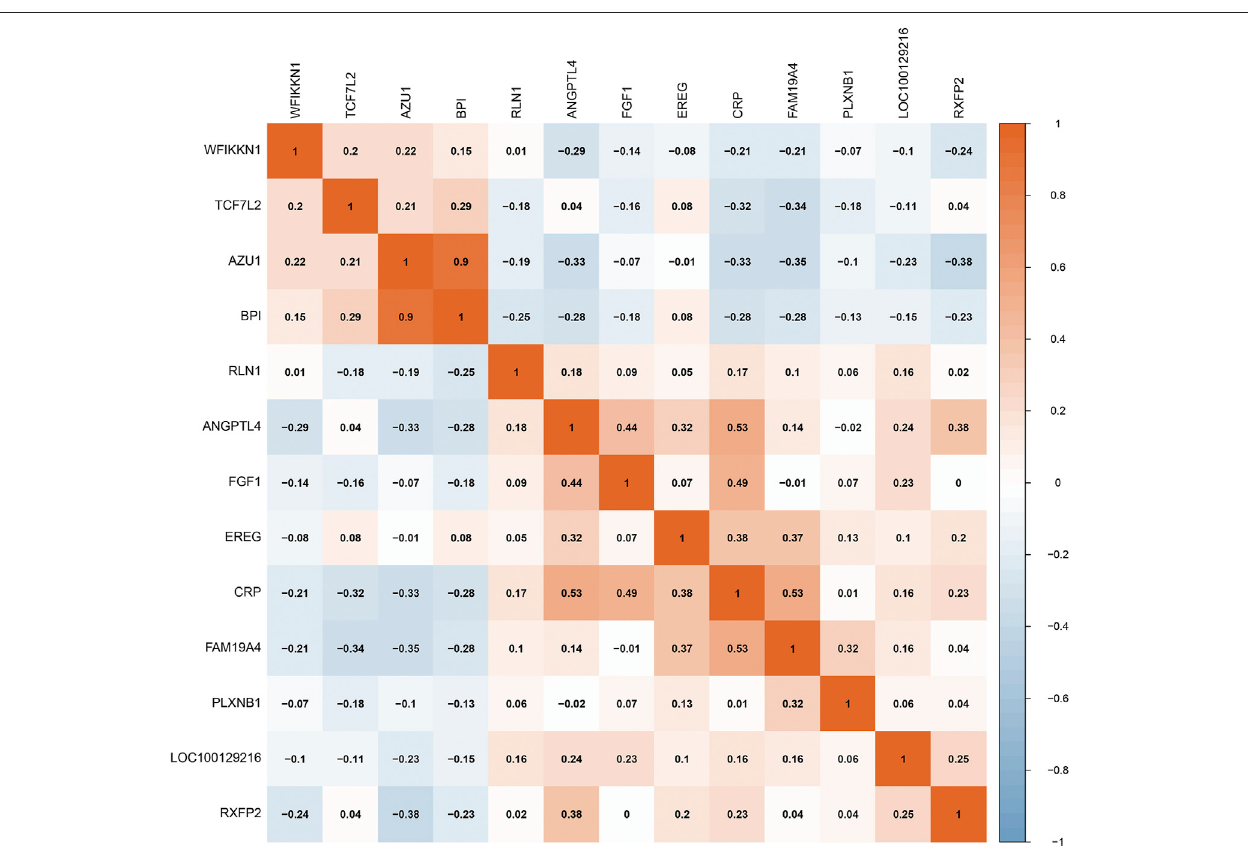
FIGURE 2 | Spearman ’ s correlation analysis of 13